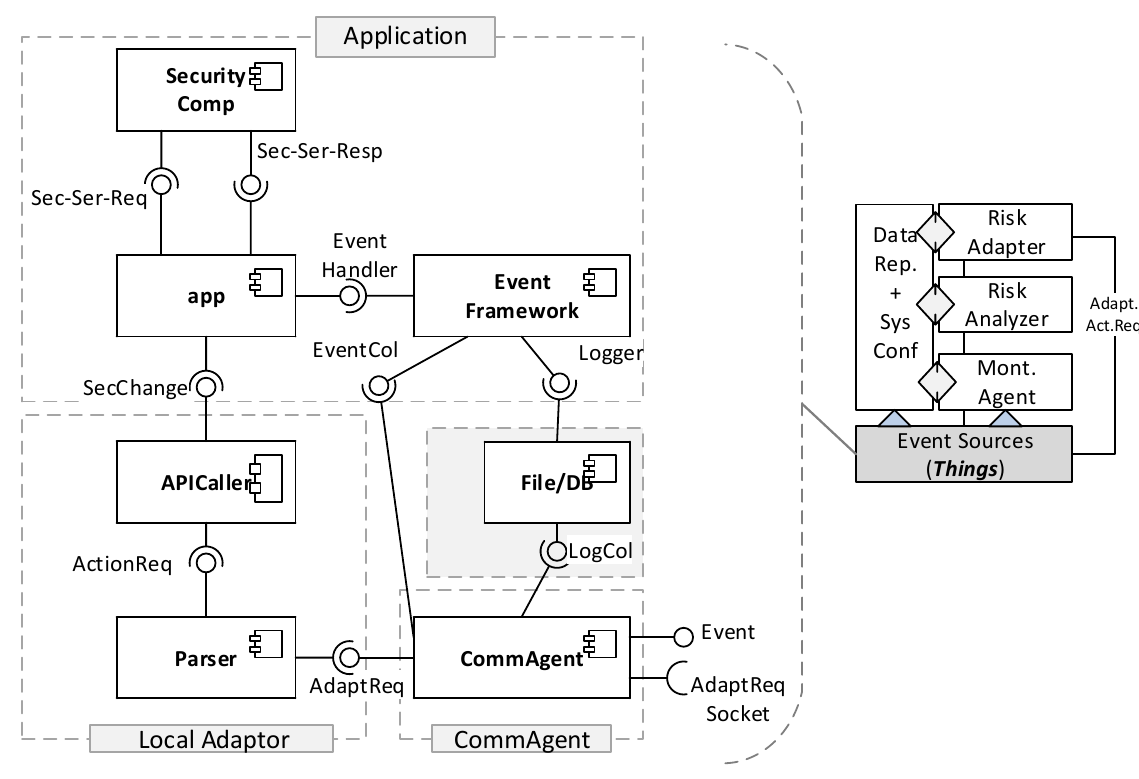
Figure 5. Local adaptation at the thing level. ( a ) Local adaptation process; ( b ) example adaptation request.